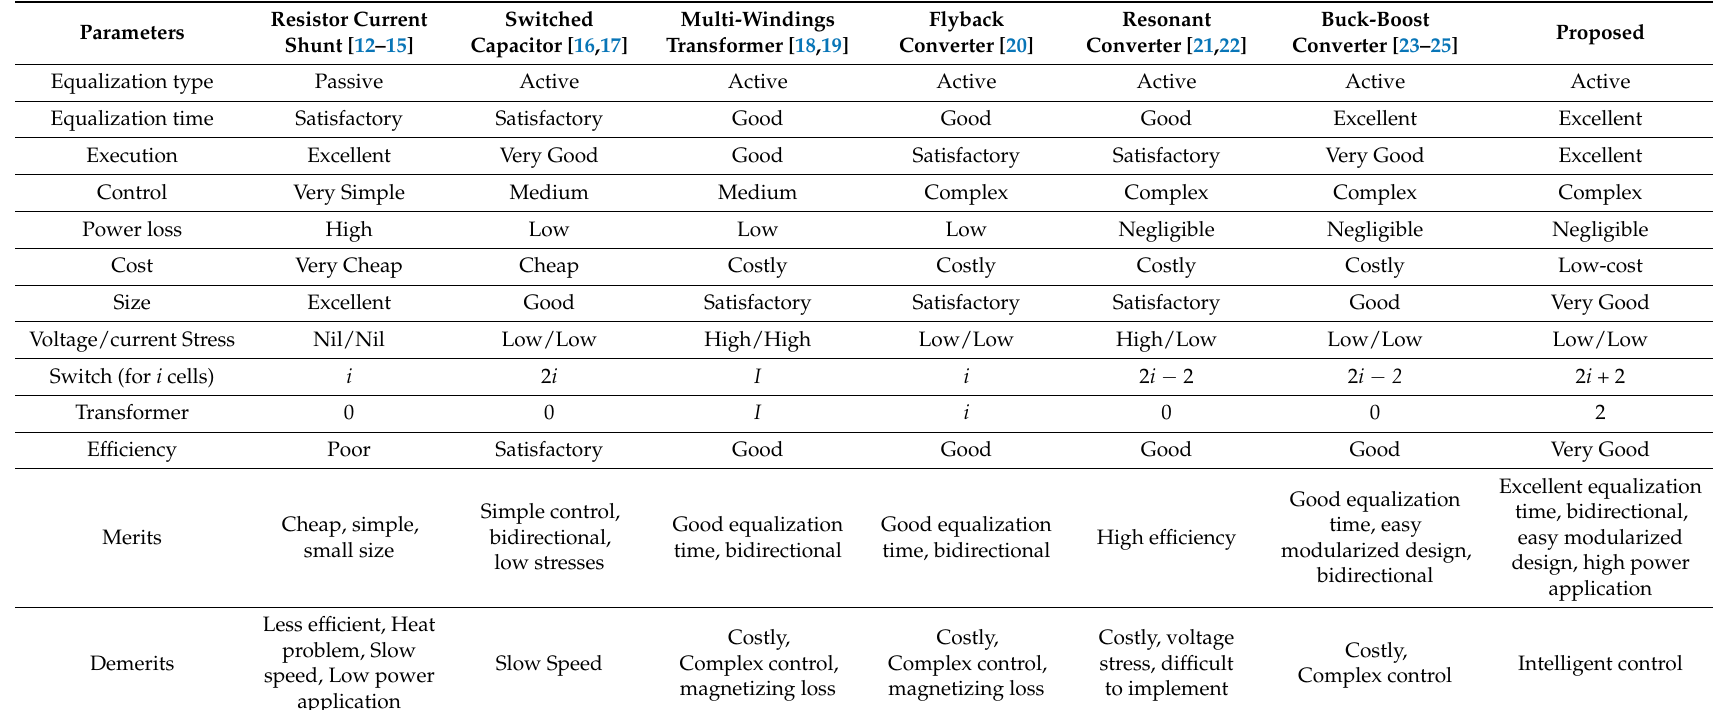
Table 2. Evaluation of the proposed charge equalization controller